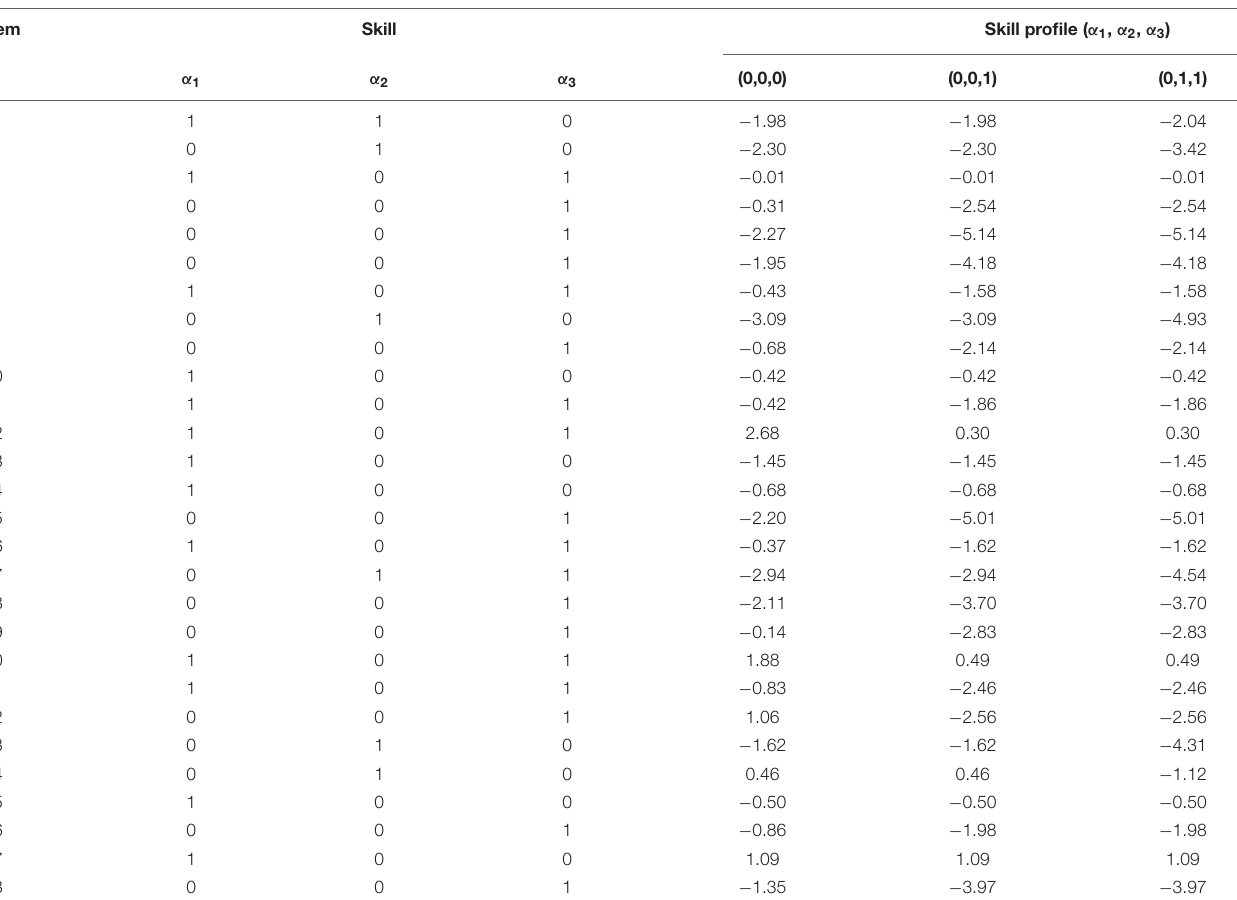
TABLE 6 | ECPE Q-matrix and hierarchical QAMRM item difficulty parameter